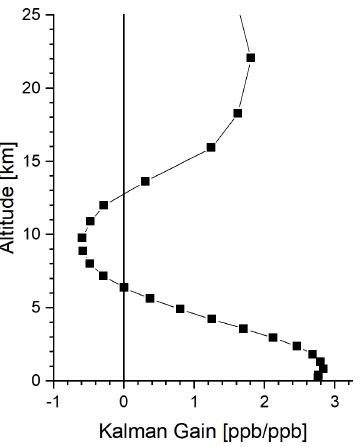
Figure 1. Visualization of a Kalman gain operator for optimally combining TROPOMI XCH 4 data with MUSICA IASI CH 4 profile data. This is the column vector m according to Eq. (2). The example shown is for a late summer atmosphere (27 September 2018) over central